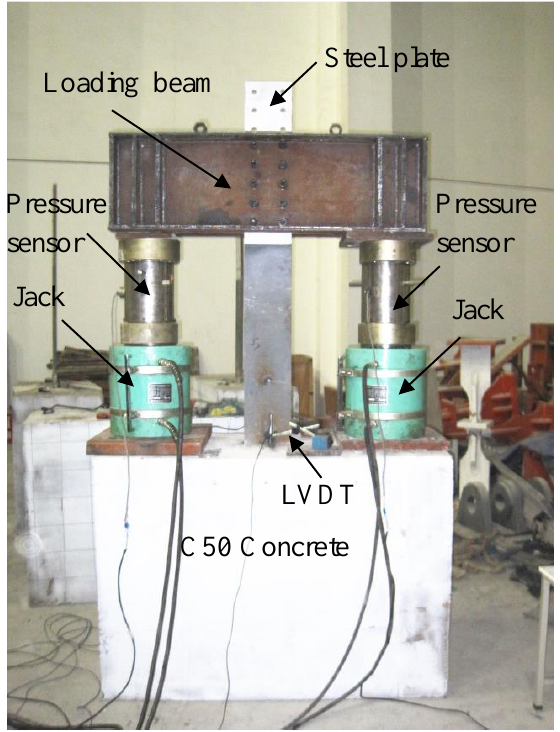
Figure 2. Pull-out test setup. LVDT: linear variable displacement transducer.